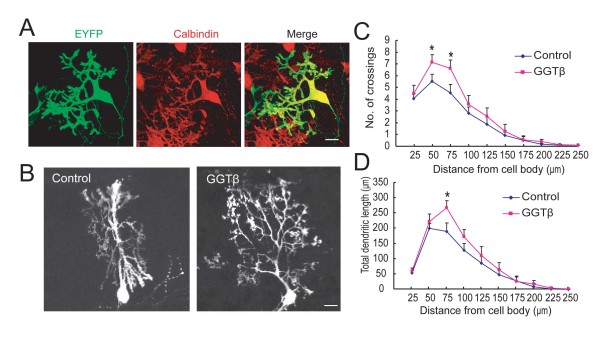
Up-regulation of GGT promotes dendrite growth and branching of PCs. Cerebellar slices of P11 rats were cultured for 2 days (DIV2) before transfection with pCAG-EYFP either alone or together with HA-GGTβ at the ratio of 1:3, followed by staining with anti-Calbindin antibody at DIV5. A) Shown is a representative PC expressing YFP, which is positively stained with Calbinin antibody. B) Representative images of HA-GGTβ or vehicle plasmid-transfected PCs. C) The number of crossings between PC dendrites and circles at indicated distance from soma is quantified to reflect dendritic branches. D) Total dendrite length between neighboring circles at the interval of 25 μm from soma is quantified. Data are shown as means ± SEM (n = 28 for control; n = 27 for HA-GGTβ). *P < 0.05. Student's t test. Scale bar is 20 μm.